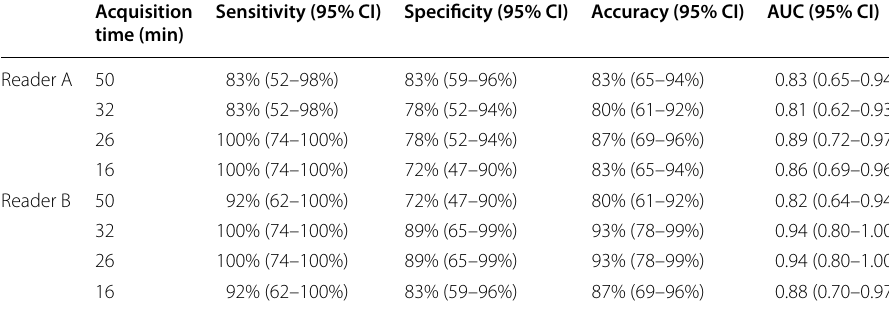
Table 3 Patient-level analysis with decreasing acquisition time